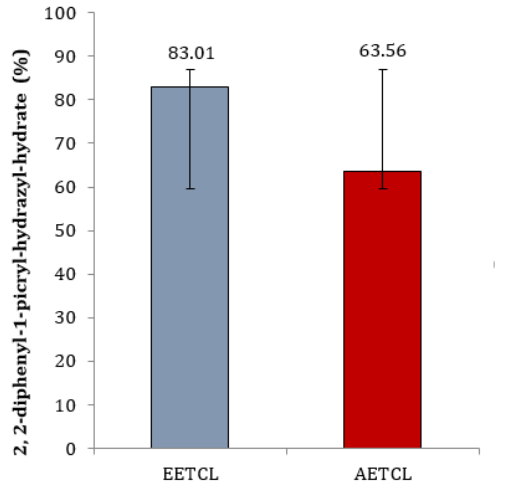
Figure 1. Quantitative phytochemistry of ethanolic and aqueous extracts of Terminalia cata ppa leaf.